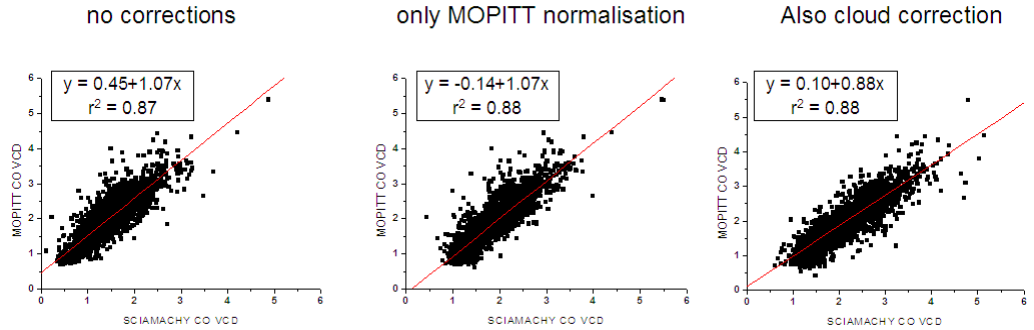
Fig. 10. Spatial correlation (1 ◦ grid) for global average maps (2003–2005) of the CO VCD from MOPITT and SCIAMACHY (units: 10 18 moleccm − 2 ) . The different graphs are for different steps of the SCIAMACHY CO